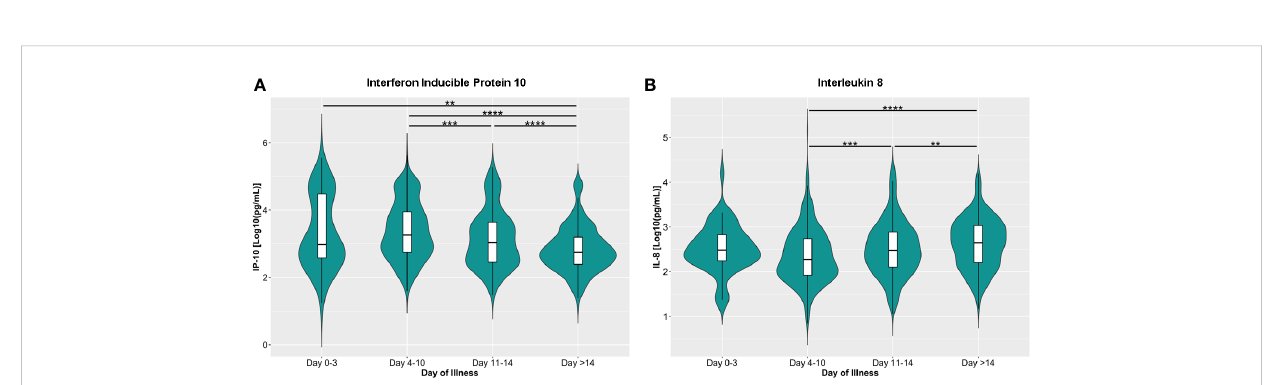
FIGURE 3 Dynamics of serum levels of (A) inducible protein 10 (IP-10) and (B) interleukin 8 (IL-8) during the disease course in the COVID-19 patient cohort. The cytokines were measured in terms of days from illness onset. All samples collected from 400 patients were strati fi ed into four intervals starting from illness onset. The dots represent individual measurement, and the box plots represent medians with interquartile range. The different groups were compared using the Kruskal-Wallis test with Dunn ’ s post hoc test. ** p <0.01, *** p <0.001, **** p <0.0001.